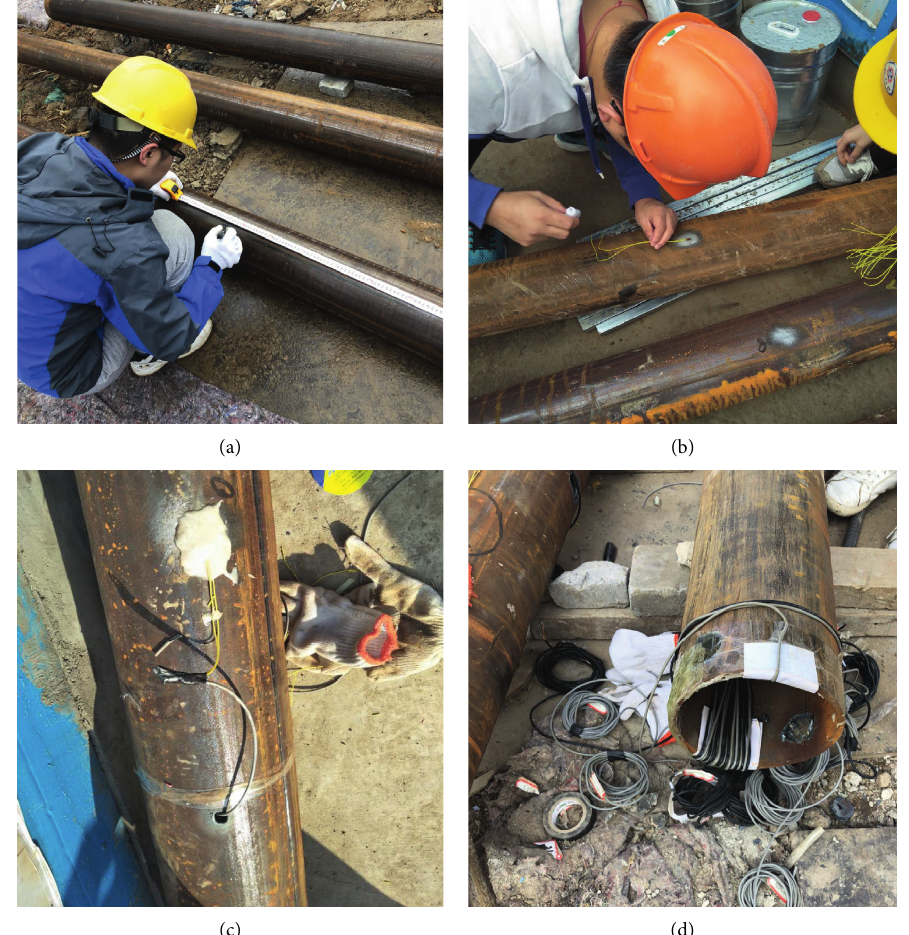
Figure 3: Schematic diagram of sensor installation process. (a) Installation location marking. (b) Strain gauge sticking. (c) Strain gauge protection. (d) Data lines